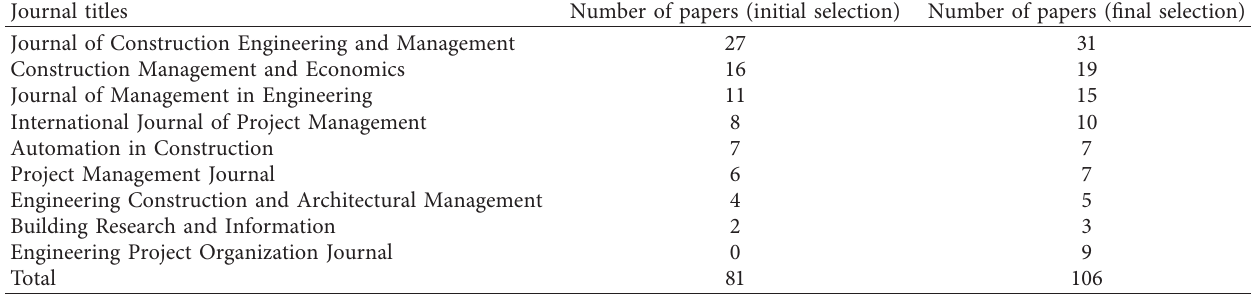
Table 1: Number of identified publications in the targeted